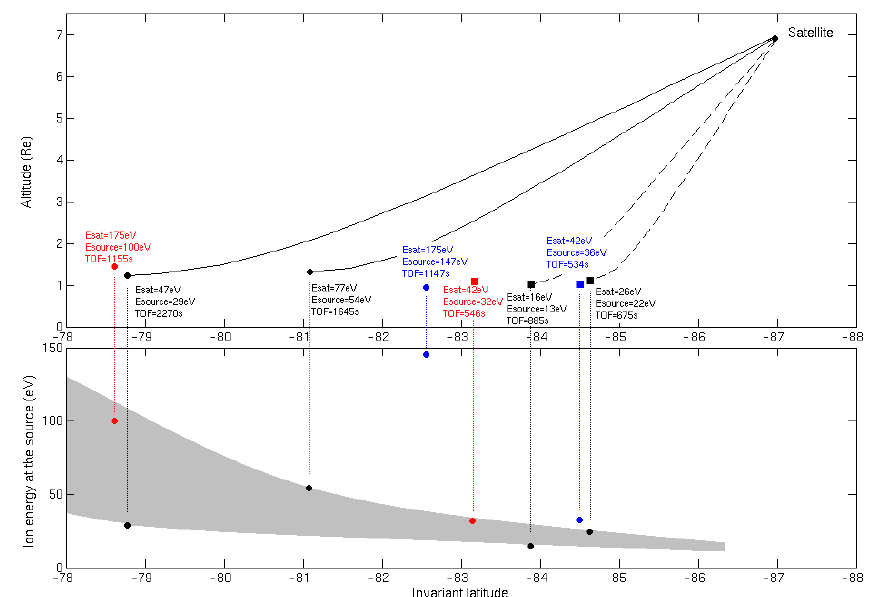
Fig. 2. Results of the backward particle simulations for the 12 November 2001 event. Top panel: Location of the mirror points in an altitude – invariant latitude diagram. The black solid lines represents O + ions trajectories for quiet conditions. The black dotted line represents H + ions trajectories for quiet conditions. The points mark the mirror points of O + (black for quiet conditions, blue for particles experiencing a short duration burst of convection and in red for particles experiencing a convection twice the regular quiet convection during their entire path from the source to the satellite). The squares mark the mirror points of H + with the same color code as for O + ions. The energy of the particles at the spacecraft and inside the source, and their computed times of flight are also indicated. Bottom panel: Corresponding particle energies at the source versus latitude. The grey region schematically represents the ion energy distribution at the source. The shape of this energy-latitude structure is defined by the backward computations and by using simple arguments about the connection between the source and the satellite: if at lower latitudes than the computed latitudes there were particles with lower energies than that computed, then they would be measured on board the spacecraft, which is not the